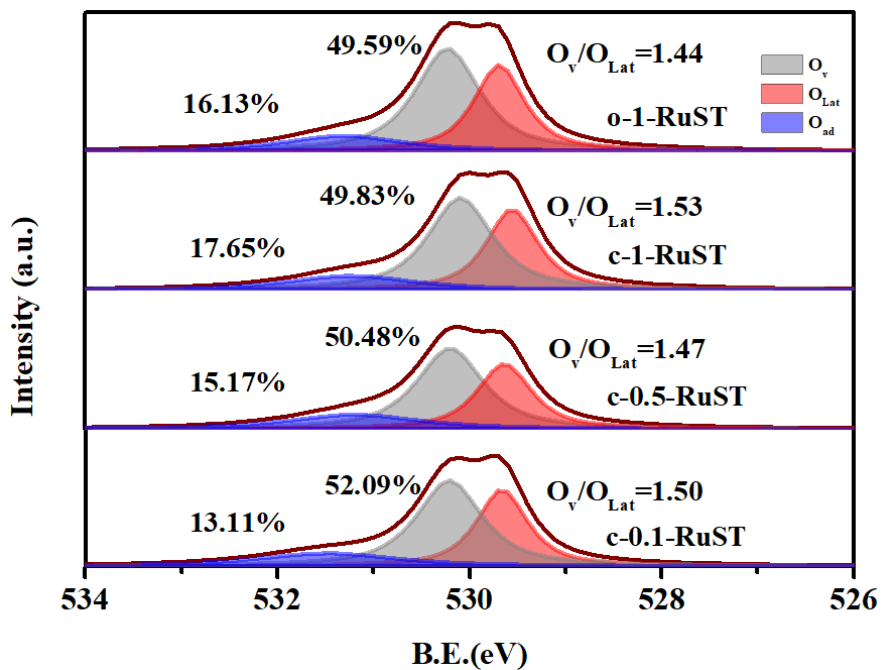
Figure 6. XPS data of O 1s for the samples. The proportion of O ad and O V in the total number of oxygen species in each sample and the oxygen vacancy concentration (O V /O Lat ) of each sample are also marked in the Figure.